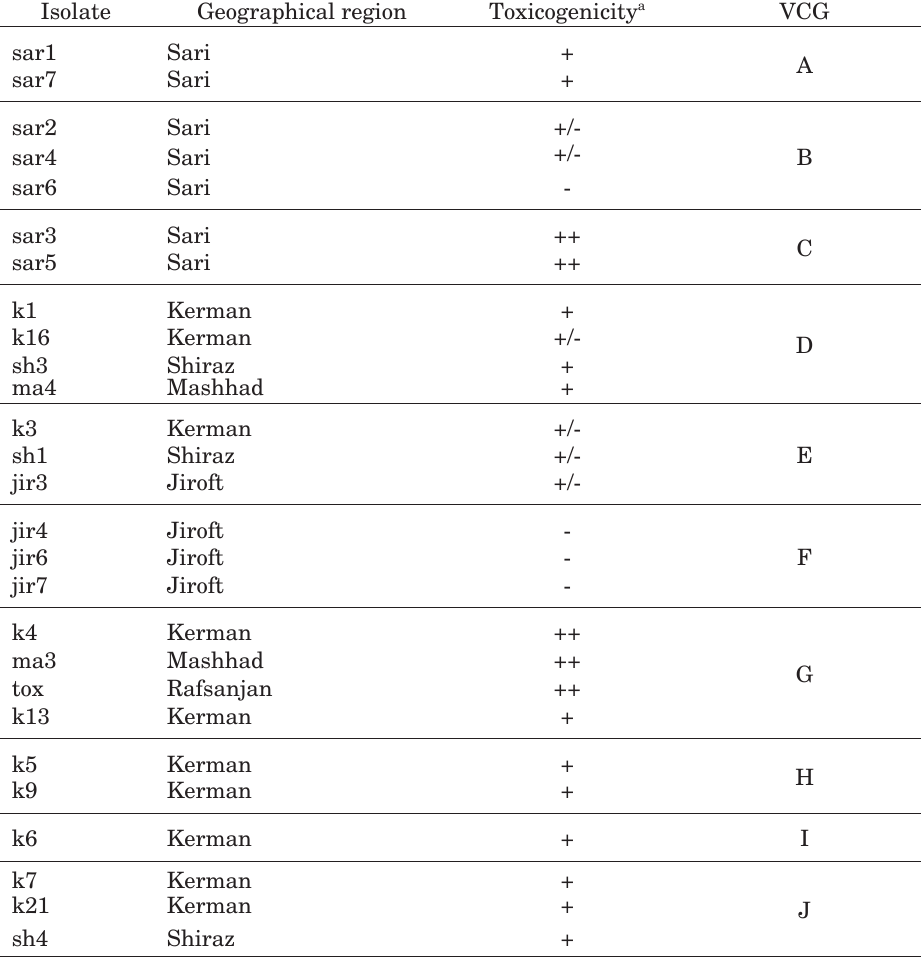
Table 1. Vegetative compatibility groups of Aspergillus fl avus isolated from sesame seeds collected from various regions of Iran. Isolate Geographical region Toxicogenicity a